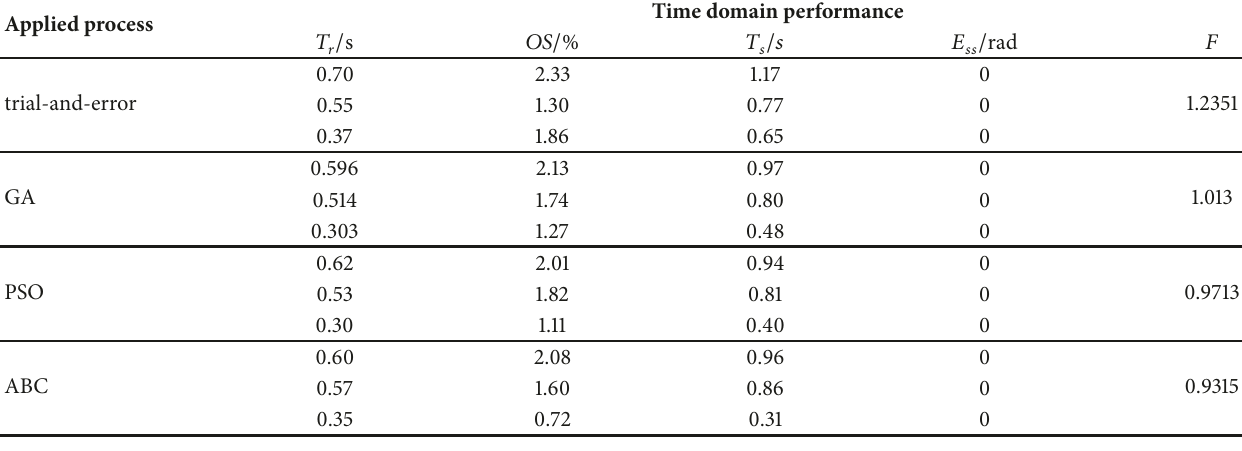
Table 2: Tuning performance of trial-and-error method, GA, PSO, and ABC algorithm.